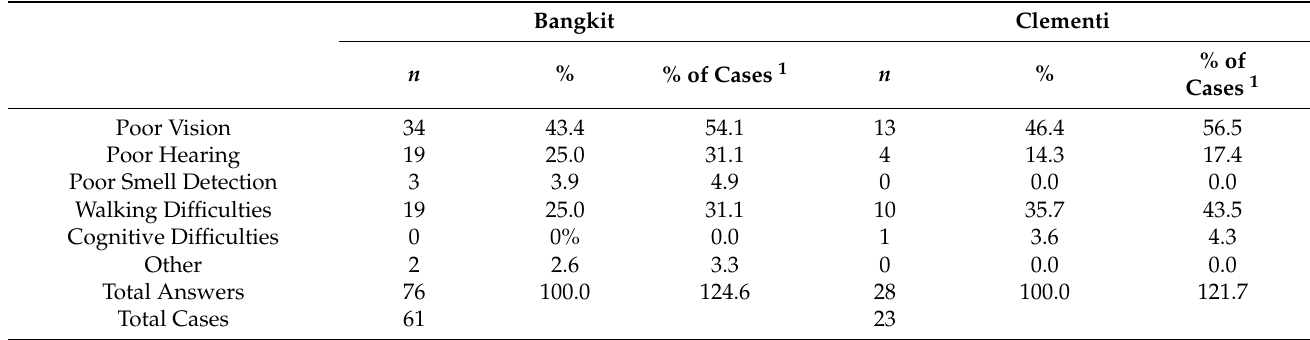
Table 4. Reported specific sensory impairments.